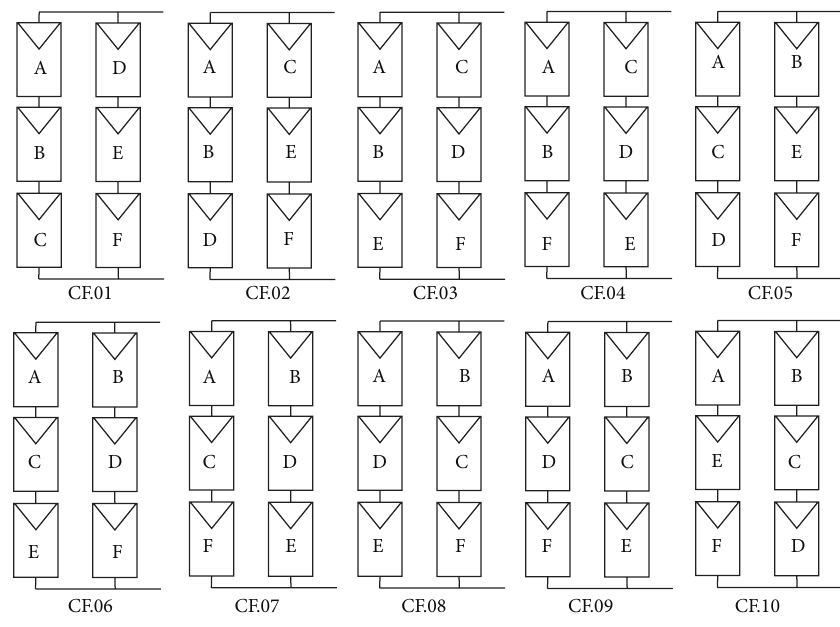
Figure 4: Settings of interest for a 3 × 2